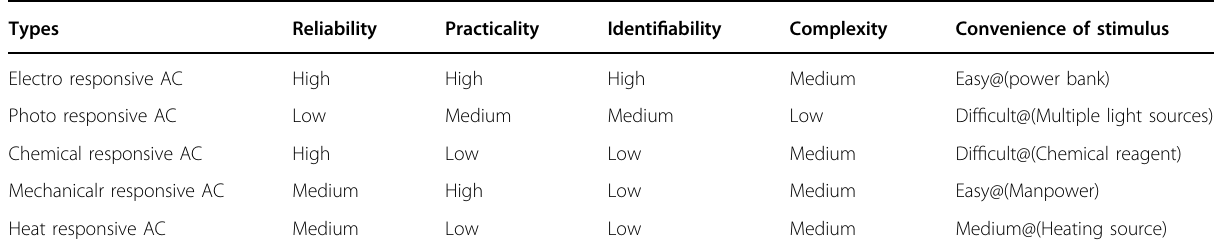
Table 1 The advantageous and disadvantageous properties of this work and the current